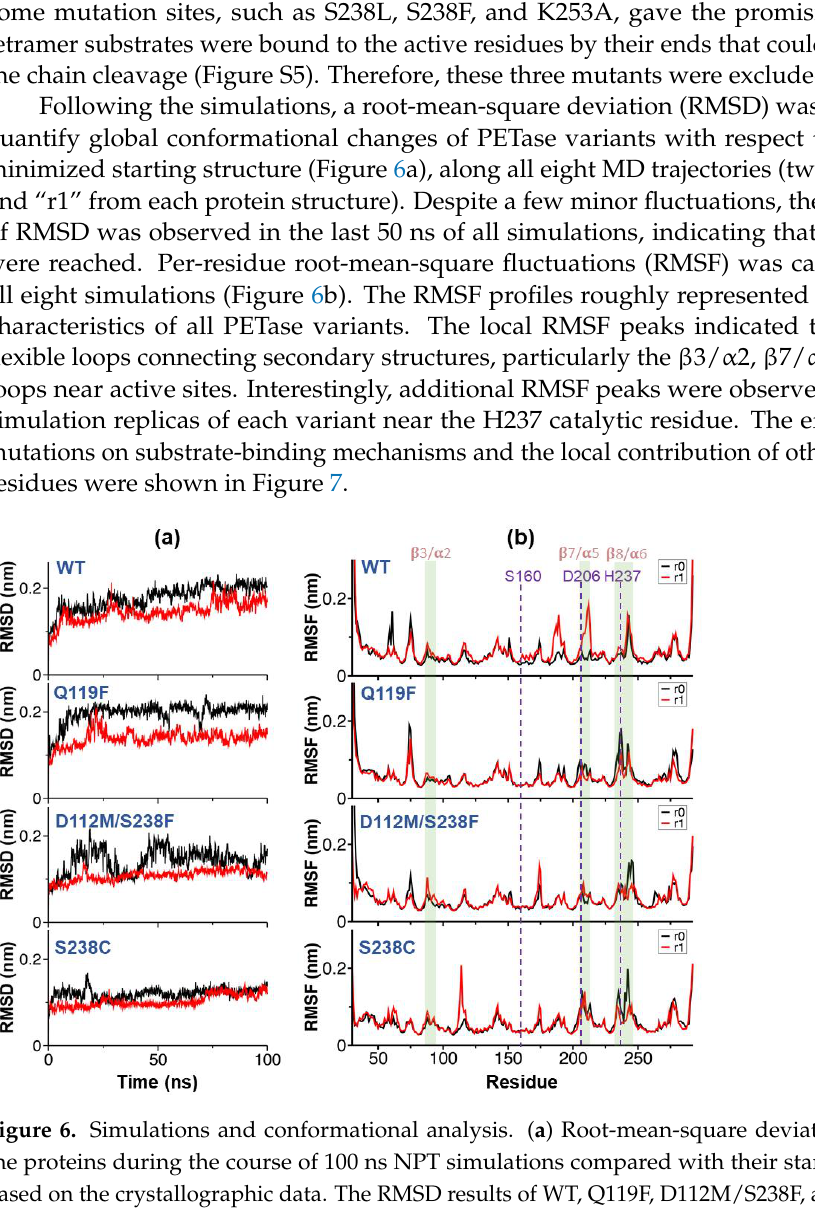
Figure 7. Conformational snapshots of the PETase and PET complex. Three-dimensional ribbon rep- resentation of the ( a ) WT PETase and its three mutants, ( b ) Q119F, ( c ) D112M/S238F, and ( d ) S238C,